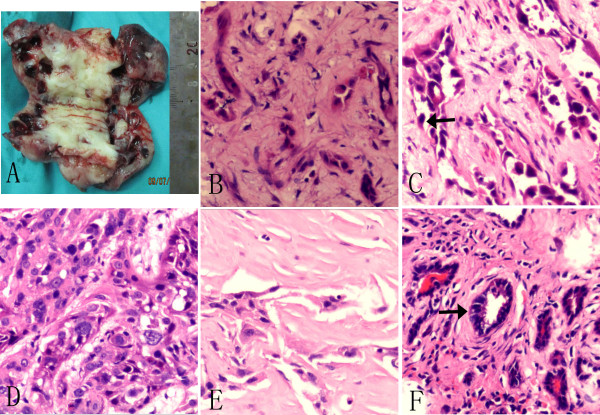
Pathological examination. A: The gray renal tumor without capsule. B: The tumor cells exhibiting a tubulopapillary architecture. C: Hobnail-shaped cells protruding into the glandular lumen (arrow). D: The tumor cells exhibiting eosinophilic property with ill-defined bound, large and atypical nuclei, and prominent nucleoli. E: The tumor interstitial connective tissue reaction. F: Collecting duct carcinoma in situ or dysplasia (indicated by an arrow).